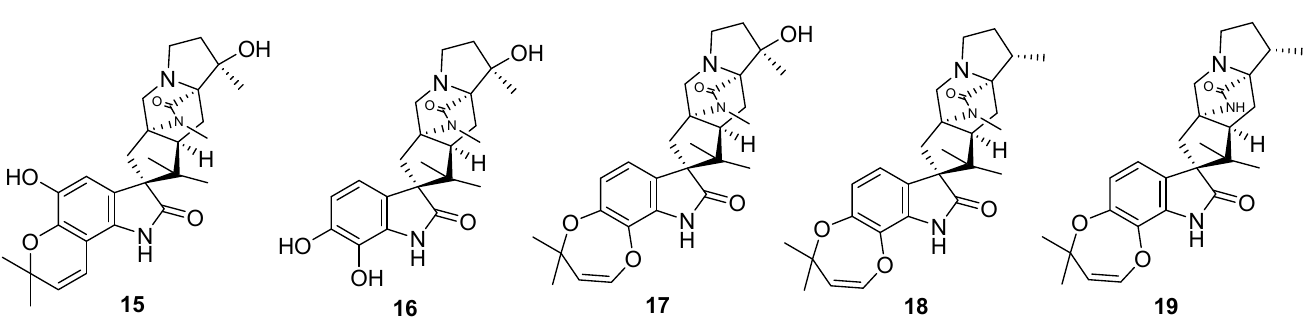
Figure 6. Monoterpenoid indoles 11 – 14 isolated from the leaves and stems of Gardneria multiflora .